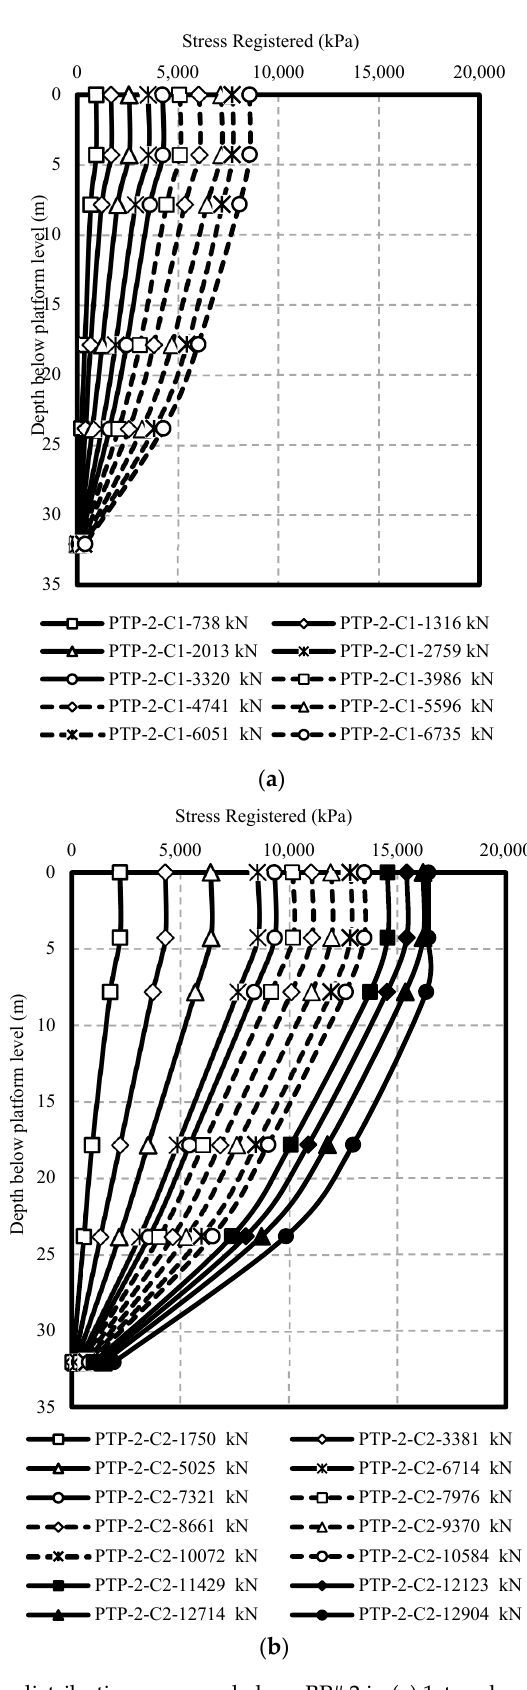
Figure 12. Stress distribution measured along BP# 2 in ( a ) 1st cycle and ( b ) 2nd cycle.